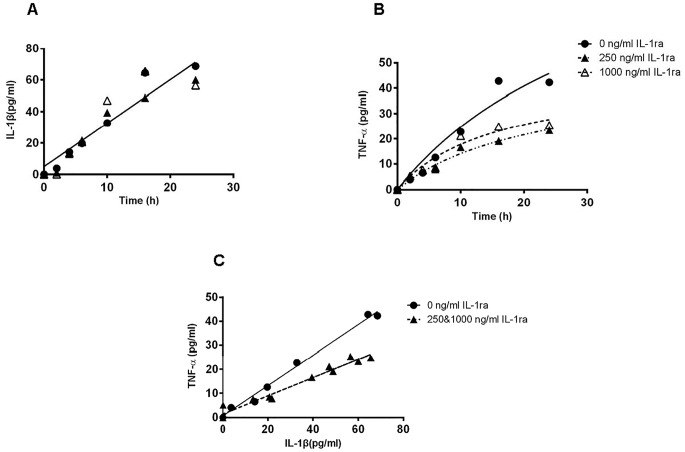
TNF-α was produced by PBMCs in an IL-1ß-dependent fashion.IL-1ß(A) and TNF-α(B) concentrations were measured in PBMC SN treated without or with IL-1ra (250 and 1000 ng/ml; 15 and 59 nM). IL-1ra was added at time 0 and SN collected at times 2, 4, 6,10, 16 and 24h. The relationship between TNF-α and IL-1ß concentrations were measured in the same samples obtained at the different times in absence or presence of IL-1ra. Data from 250 and 1000 ng/ml IL-1ra-treated samples were pooled (Fig 1C). Data are expressed as pg/ml from 2x104 cells in 96 well plates. This experiment has been repeated twice.